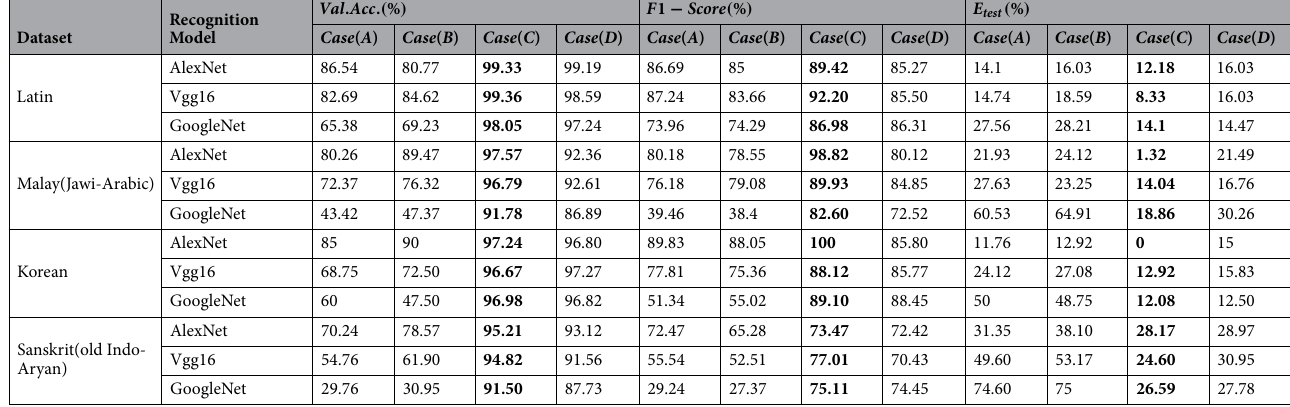
Table 4. The recognition results of AlexNet, VGG-16, and GoogleNet models under the different training cases for each dataset. Significant values are in [bold].